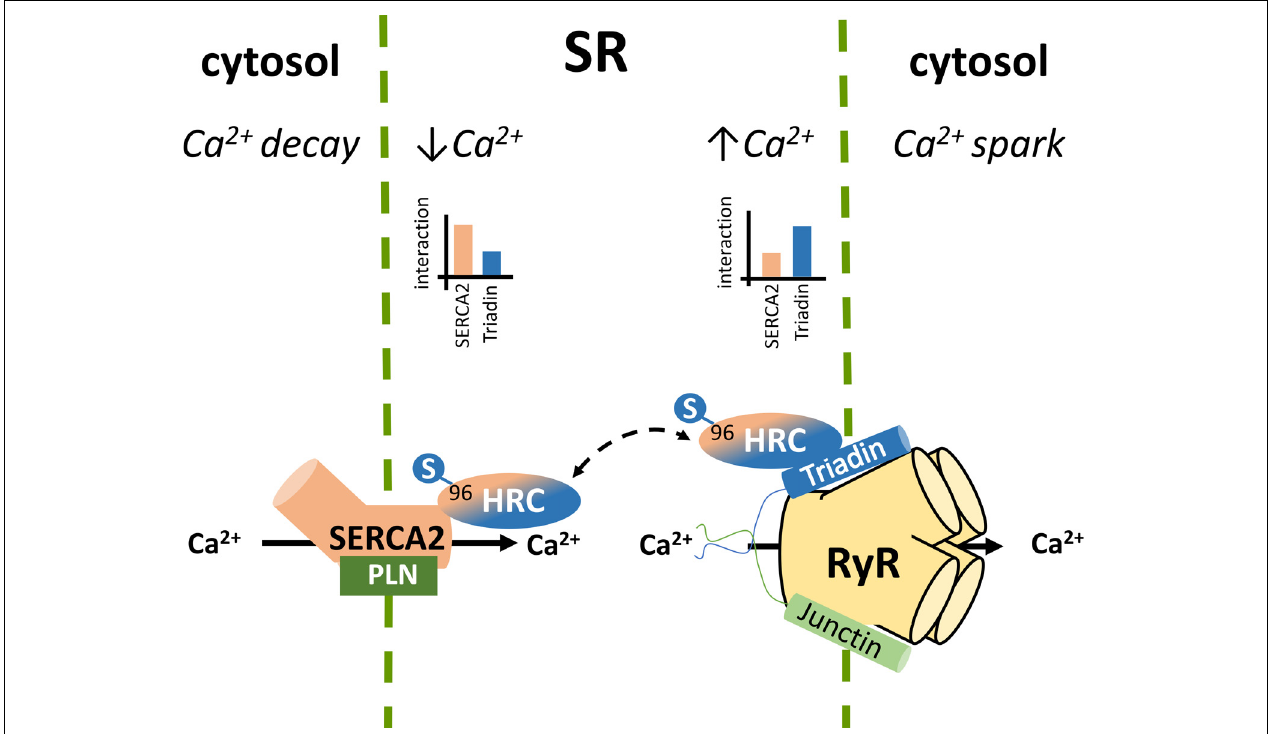
FIGURE 1 | Histidine-rich calcium binding protein complex cellular interactions within the cardiomyocytes. Local SR Ca 2 + changes alter the dynamics of HRC interactions with triadin and SERCA2.